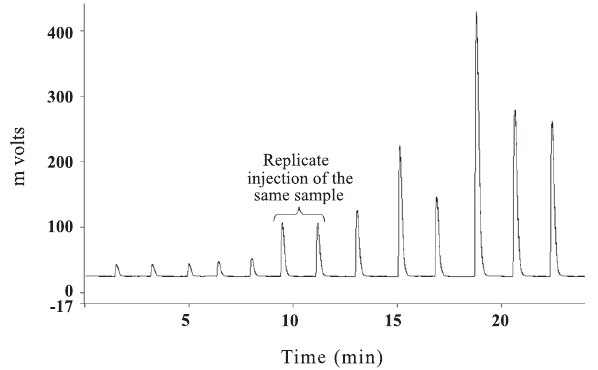
figure 5. trace of samples illustrating replication and rapid turnaround of samples with each peak, representing an individual sample injection.